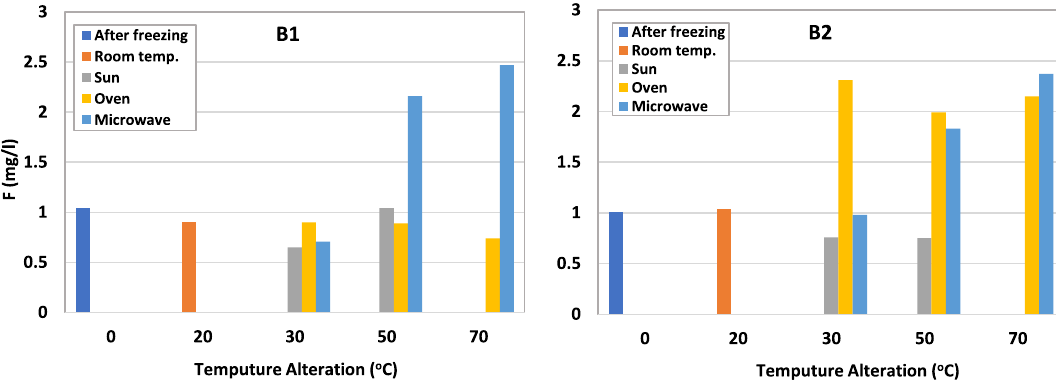
Fig. 4 Fluoride concentrations at different heating degrees for brands B1 and B2